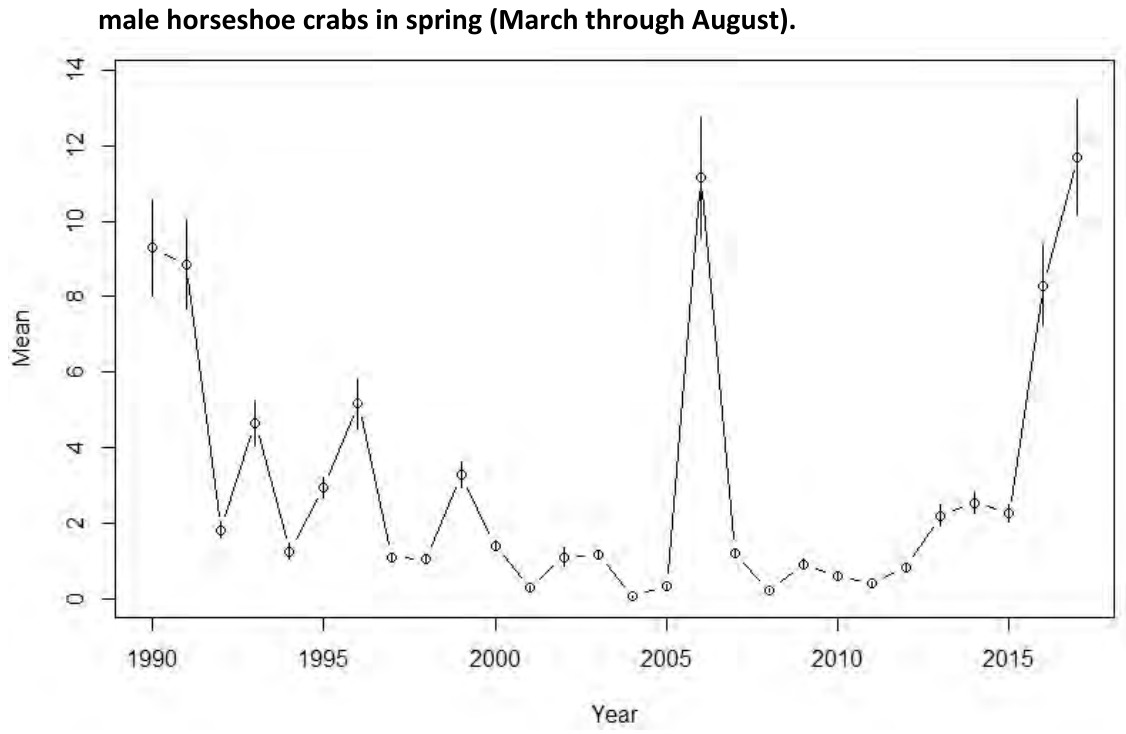
Figure 56. Delaware Fish and Wildlife Adult Trawl Survey abundance index for all adult horseshoe crabs combined in fall (September through